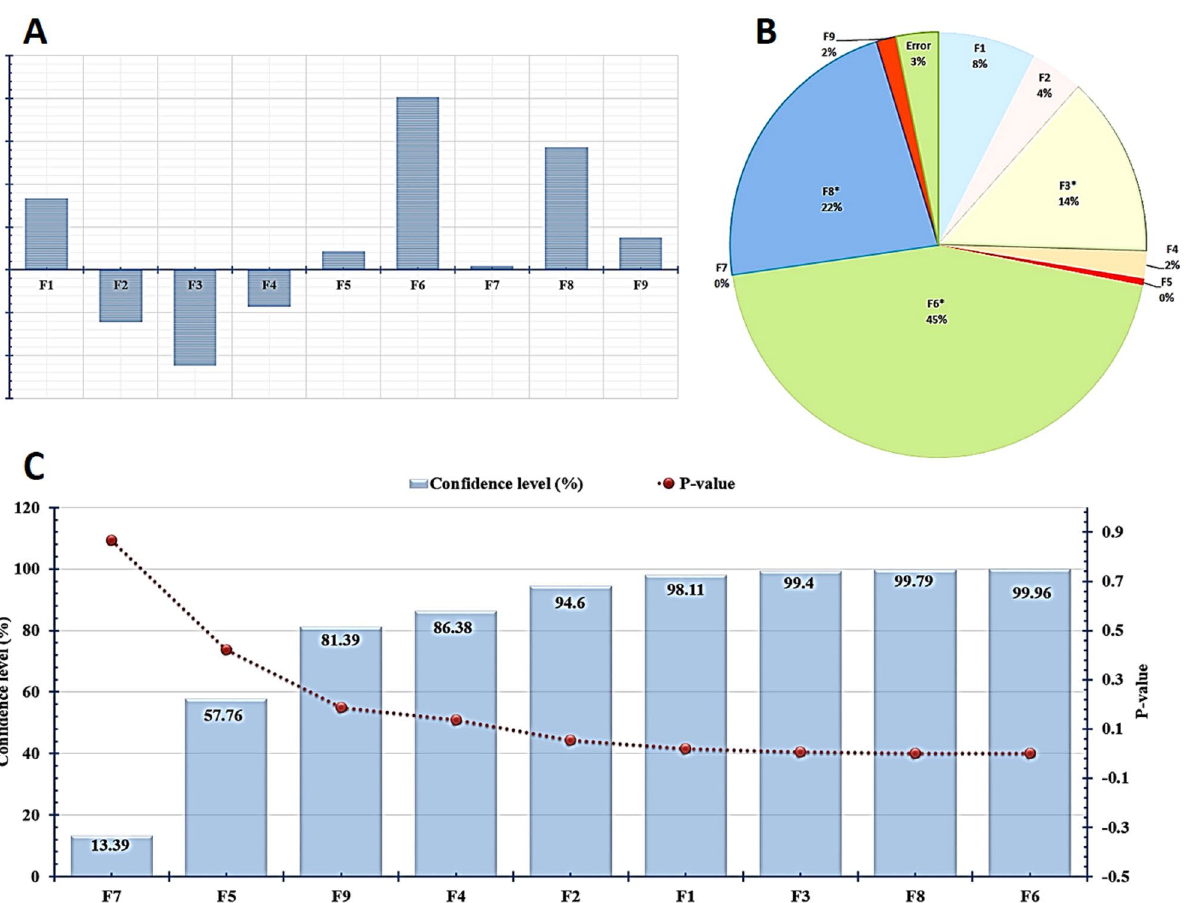
Figure 7. Statistical analysis showing effects of tested variables on dry cell mass of entophytic Trichoderma virens strain EG92 according to Plackett–Burman design. ( A ) Column chart of calculated main effect of tested variables, ( B ) Pie chart of percent distribution of each variable, and ( C ) Pareto chart represents the calculated p -value and confidence